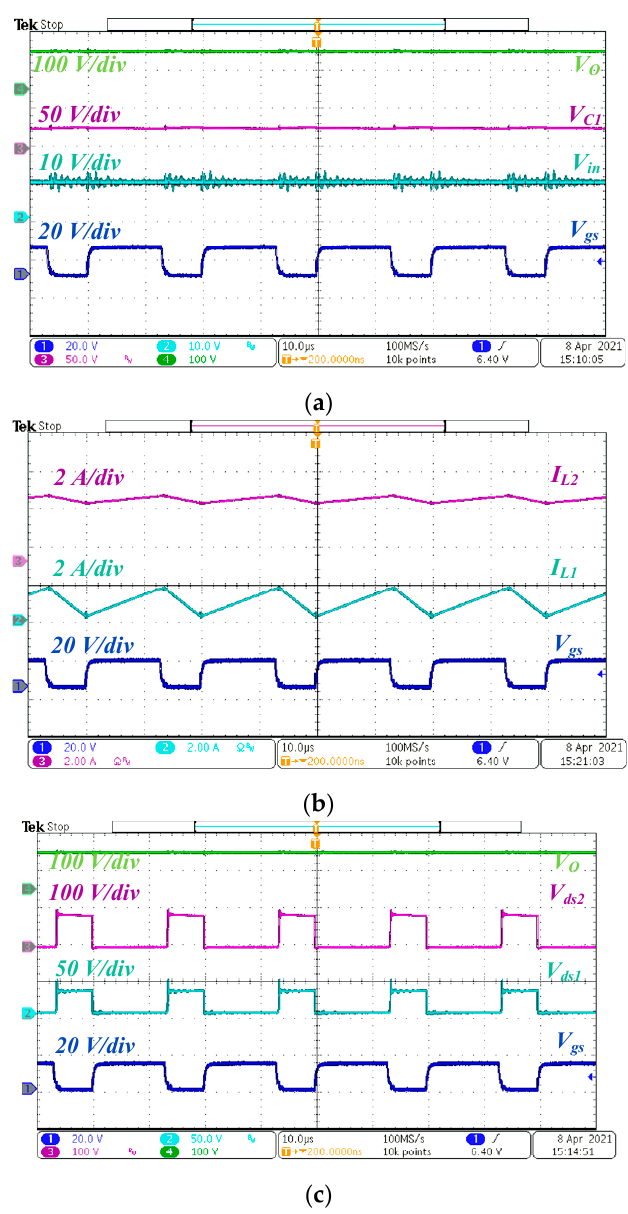
Figure 9. Experimental results at V in = 10 V, D = 0.65 . ( a ) V o , V C1 , and V in . ( b ) I L1 and I L2 . ( c ) V o , V ds1 , V ds2 . V ds1 , V ds2